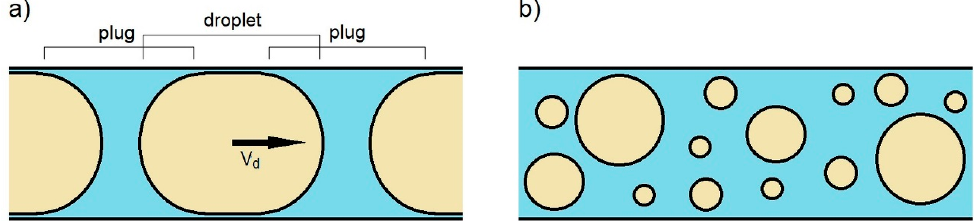
Figure 1. Transport of emulsions when: ( a ) the diameter of the dispersed phase is comparable in size to the channel diameter; ( b ) the average diameter of the droplets is much smaller than the channel diameter.